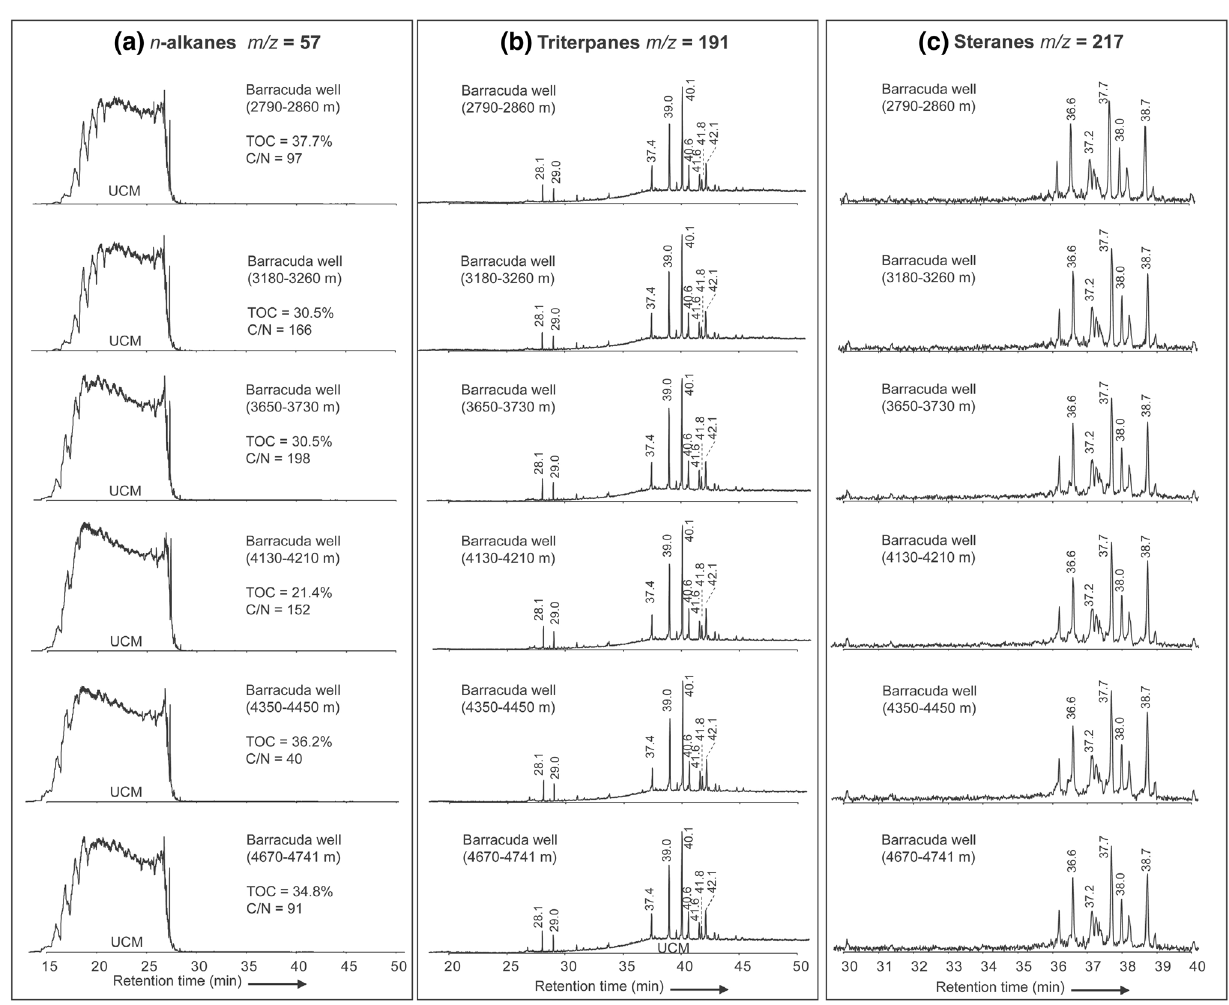
Fig. 2 Mass chromatograms showing distribution of a n -alkanes ( m / z = 57), b triterpanes ( m / z = 191), and c steranes ( m / z = 217) fractions in oil- based drilling mud